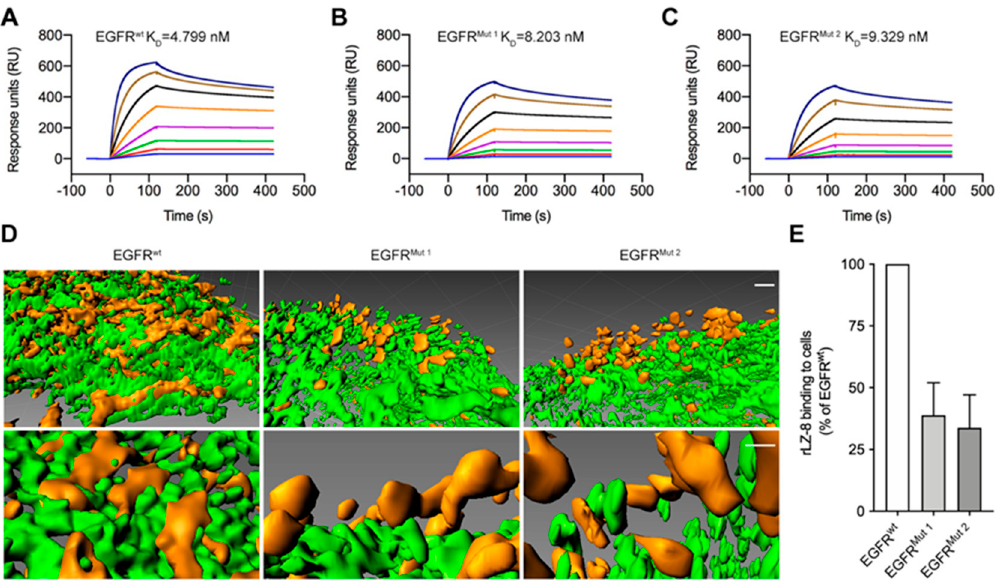
Figure 7. (S222, K269) was the binding sites of EGFR related to intense internalization. ( A–C ) Biacore analysis. rLZ-8 was immobilized onto sensor chips and EGFR wt EGFR Mut 1 or EGFR Mut 2 were injected at concentrations ranging from 4 nM to 512 nM. K D values were shown on panels. ( D ) 10 μ g/mL rLZ-8 (red) was treated on NIH-3T3-EGFR wt / Mut 1 / Mut 2 cells, with EGFR (green) coloring by immunofluorescence. Surface rendering was generated from Imaris. Scale bars above, 2 μ m, bottom, 1 μ m. ( E ) The binding quantity of rLZ-8 to cells was analyzed by Imaris software. All data are means ± SD.